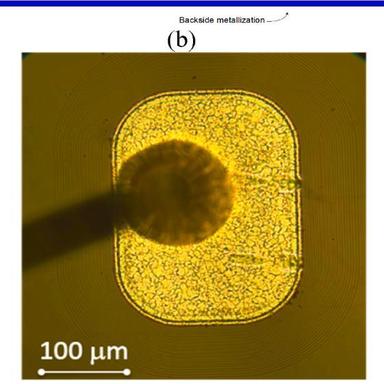
a) Schematic showing the half-vertical PiN diodes shielded by 22 field rings. b) picture of the diode with the gold ball bonding of 50 μm in diameter.